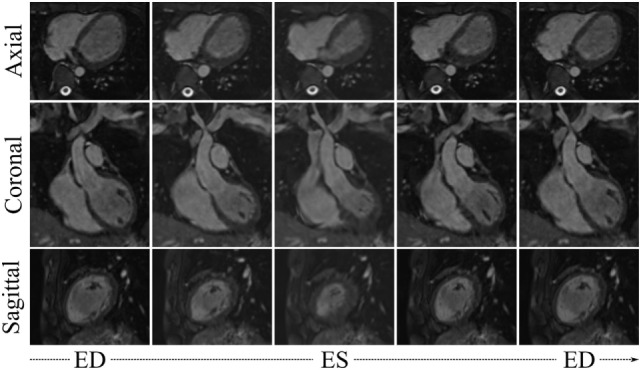
WHSyn,jt from 5 evenly spaced frames of the cardiac cycle of the subject j = Control2, obtained by propagating the subject’s motion from the cine dataset onto the high-resolution WH image.